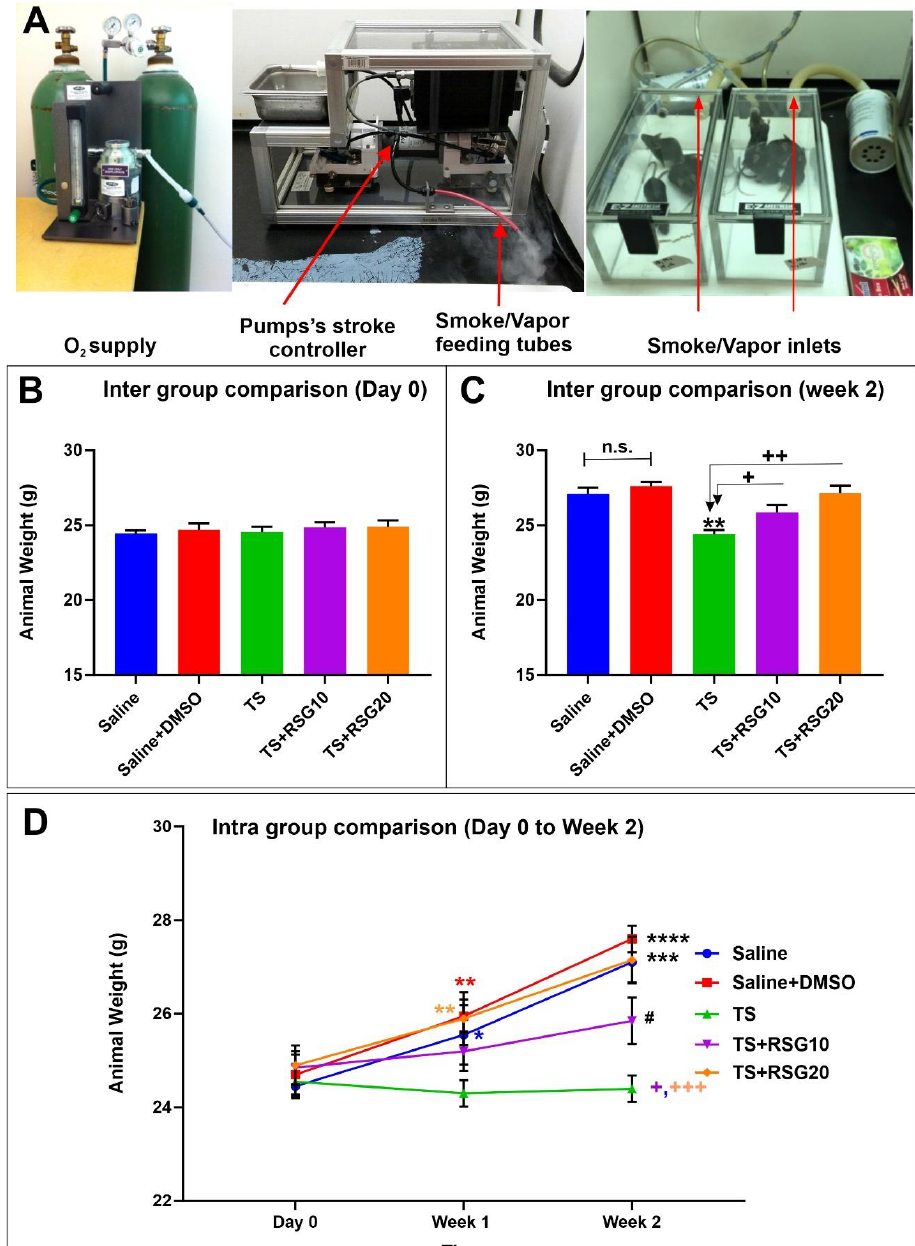
Figure 1. Effect of saline/DMSO/rosiglitazone (RSG) treatments with/without tobacco smoking’s (TS) exposure on body weight in vivo. ( A ) Set-up of the exposure of mice with chronic exposure to the TS. ( B ) Measurements of animals’ body weight did not show any significant difference between the tested groups at Day 0, however, at the end of the 2 weeks exposure ( C ), animal exposed to TS showed a significant lower body weight when compared to controls. The effect was abrogated by co-treatment with RSG. ( D ) Longitudinal assessment of animals’ body weight (all groups). Test mice also received a daily intraperitoneal injection of RSG. At the end of the experiment, brain tissue was collected, homogenized and processed for biochemical and molecular preparations. n = 4 biological replicates. * p < 0.05, ** p < 0.01, *** p < 0.001 and **** p < 0.0001 versus saline. + p < 0.05, ++ p < 0.01, +++ p < 0.001 versus TS. # p < 0.05 TS + RSG 20 versus TS + RSG 10. n.s. = non statistical